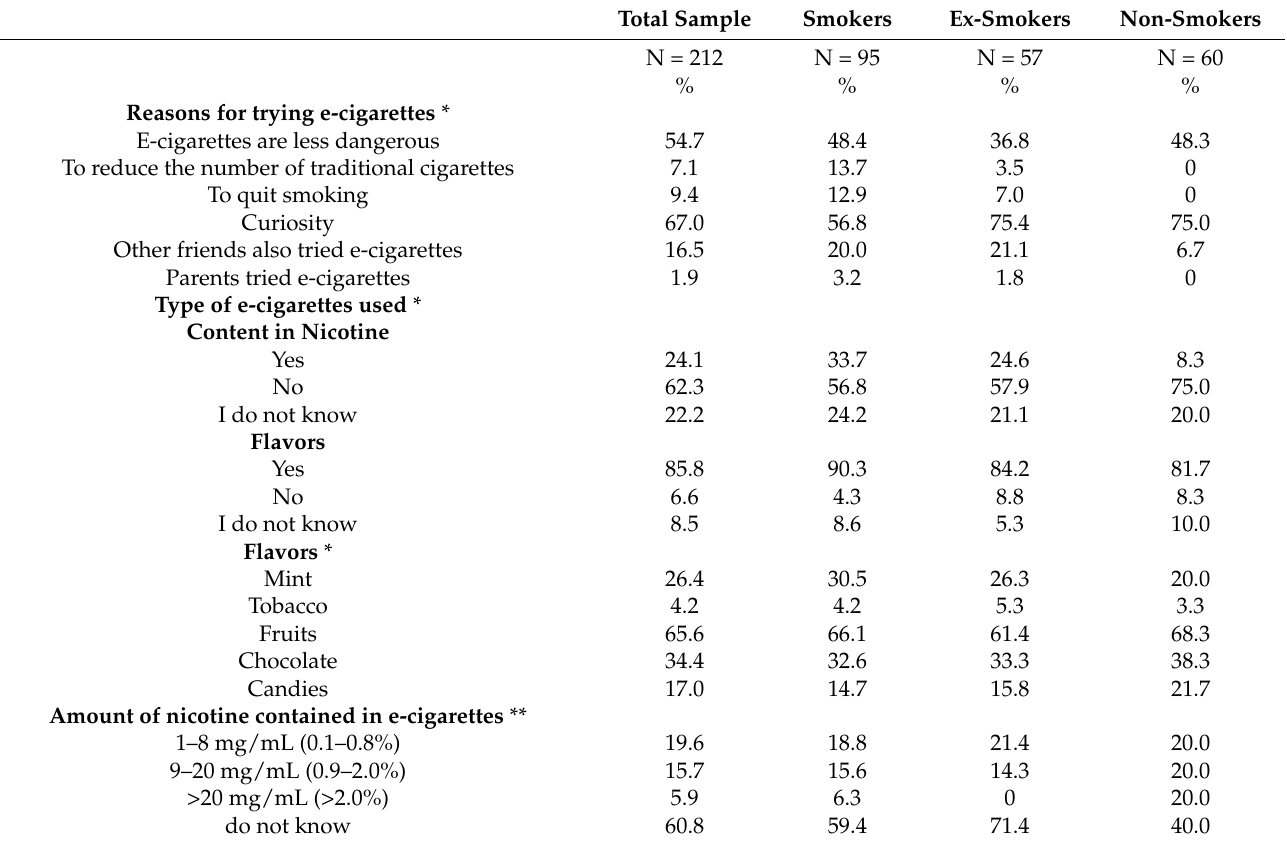
Table 2. Reasons for trying e-cigarettes and types of e-cigarettes